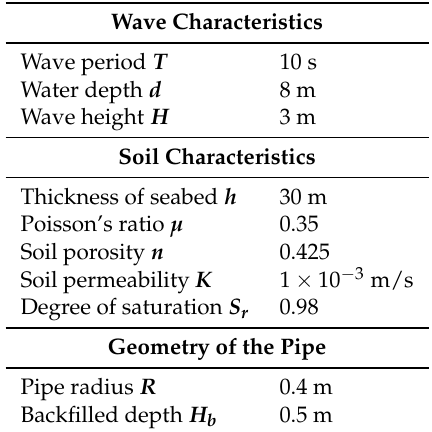
Table 4. Input data for the parametric